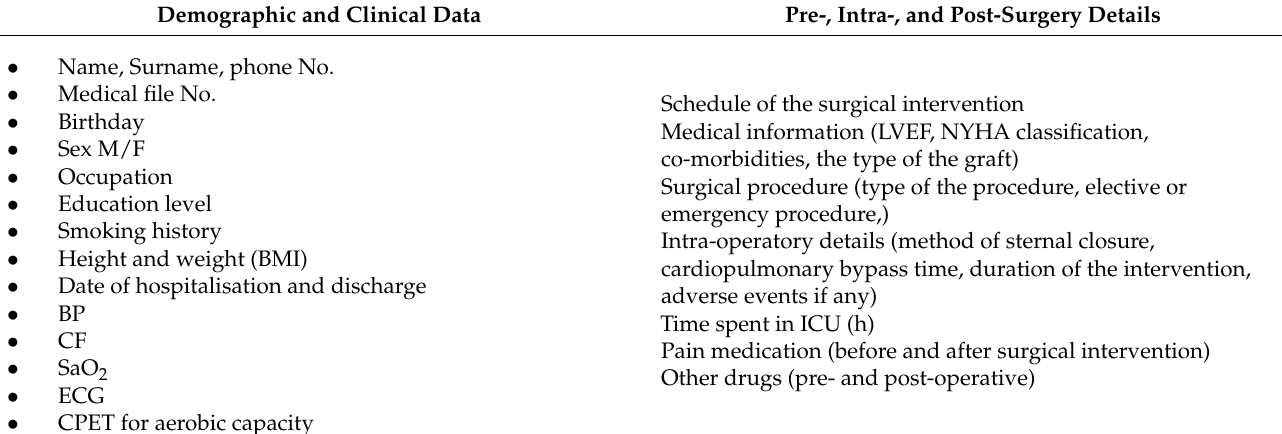
Table 2. Recordings of demographic and clinical data. Demographic and Clinical